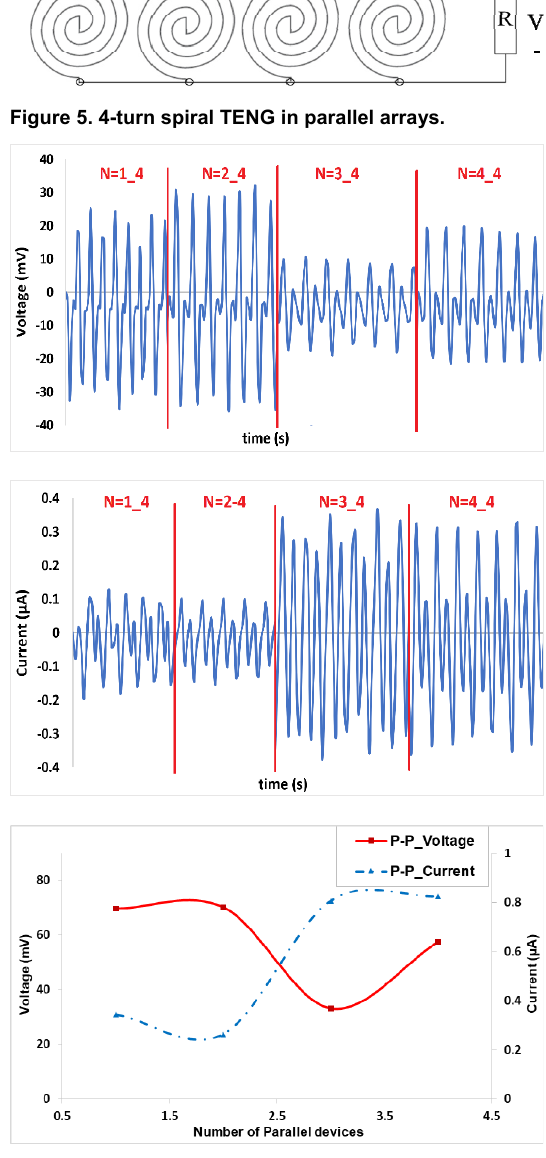
Figure 6. Measured parameters for the structures with different numbers of parallel, a) output voltages, b) output currents, c) compared values for output voltages and currents vs. several parallel devices.